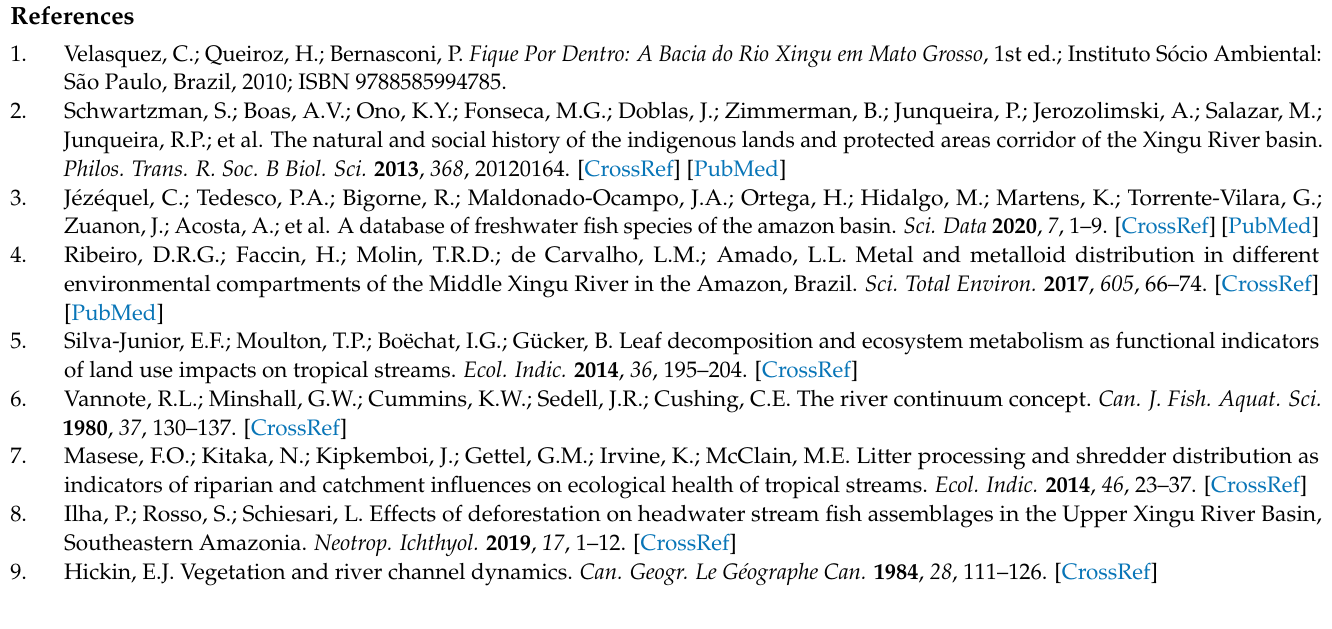
Supplementary Materials: The following are available online at https://www.mdpi.com/article/ 10.3390/toxics10040182/s1: Table S1: Comparison between 1985 and 2020 of land use classes and Table S2: Comparison between 1985 and 2020 of land use classes and vegetation cover at the P1XR site, in the municipality of S ã o F é lix do Xingu, Par á state, Brazil, Table S3: Comparison between 1985 and 2020 of land use classes and vegetation cover at the P2FR site, in the municipality of S ã o F é lix do Xingu, Par á state, Brazil, Table S4: Comparison between 1985 and 2020 of land use classes and vegetation cover at the P3XFR site, in the municipality of S ã o F é lix do Xingu, Par á state, Brazil, Table S5: Concentrations of Mn and Zn ( µ g · L − 1 ) in water samples from P1XR and P2FR, Table S6: Concentrations of total solids (mg · L − 1 ) in water samples from P1XR and P2FR, Table S7: Turbidity (UT) of water samples from P1XR and P2FR, Table S8: Principal component analysis (based on the correlation matrix), Table S9: Principal component analysis loadings, considering the following variables: Mn, Zn, avoidance (AVO), total solids (TS), turbidity (TB), area with forest (FOR), aquatic invertebrate abundance (ABU), and aquatic invertebrate diversity (DIV), Table S10: Numbers of zooplankton collected, according to family (morphotypes), showing the abundance and diversity of the organisms, Table S11: Distribution of A. bimaculatus in the control test with well water, Table S12: ANOVA applied to the distribution of the organisms in the control test, Table S13: Distribution of A. bimaculatus in the test with water from P1XR, P3XFR, and P2FR, Table S14: One-way ANOVA applied to the distribution of the organisms in the test with water from P1XR, P3XFR, and P2FR, Table S15: Tukey’s test pairwise comparisons ( p < 0.05) for the distribution of the organisms in the test with water from P1XR (C1 and C2), P3XFR (C3 and C4), and P2FR (C5 and C6) in the avoidance